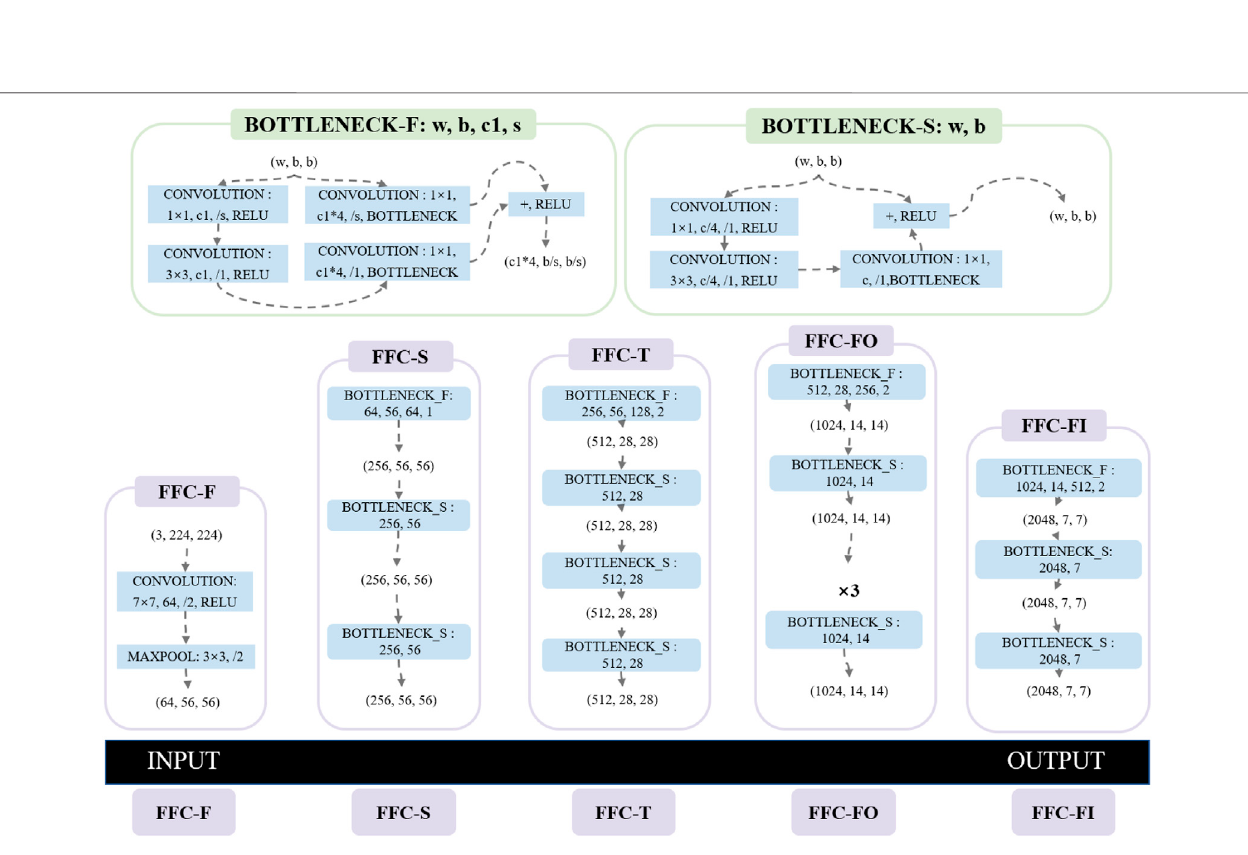
FIGURE 4 | Residual Network CNN framework and structured data propagation